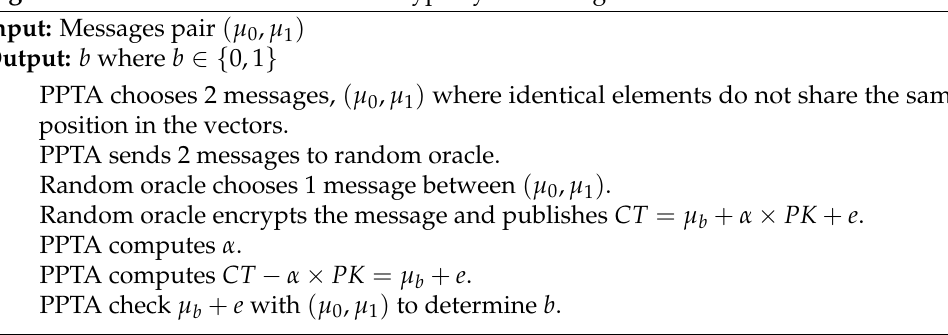
Algorithm 5 IND -CPA on the AAK-Cryptosystem using Theorem